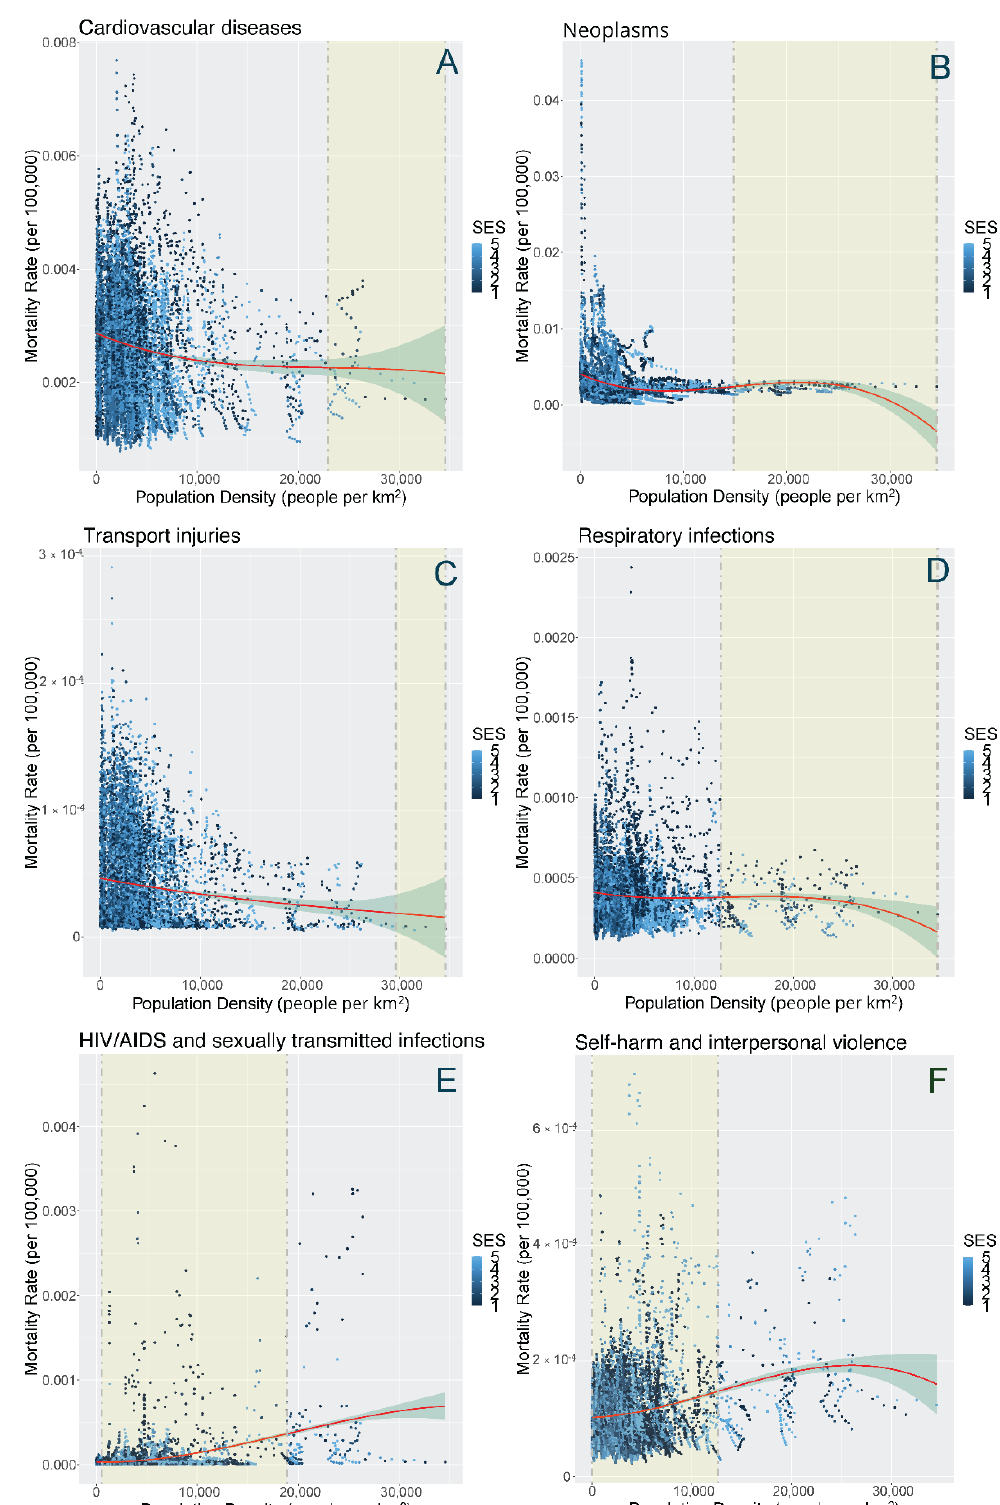
Figure 5. Smoothed cubic splines with the shaded areas representing the ‘optimal range’ identified of population density (people per km 2 ) and six cause-specific mortality rates: ( A ) cardiovascular diseases; ( B ) neoplasms; ( C ) transport injuries; ( D ) respiratory infections; ( E ) HIV/AIDS and sexually transmitted infections; and ( F ) self-harm and interpersonal violence, Metro Vancouver, 1990– 2016.